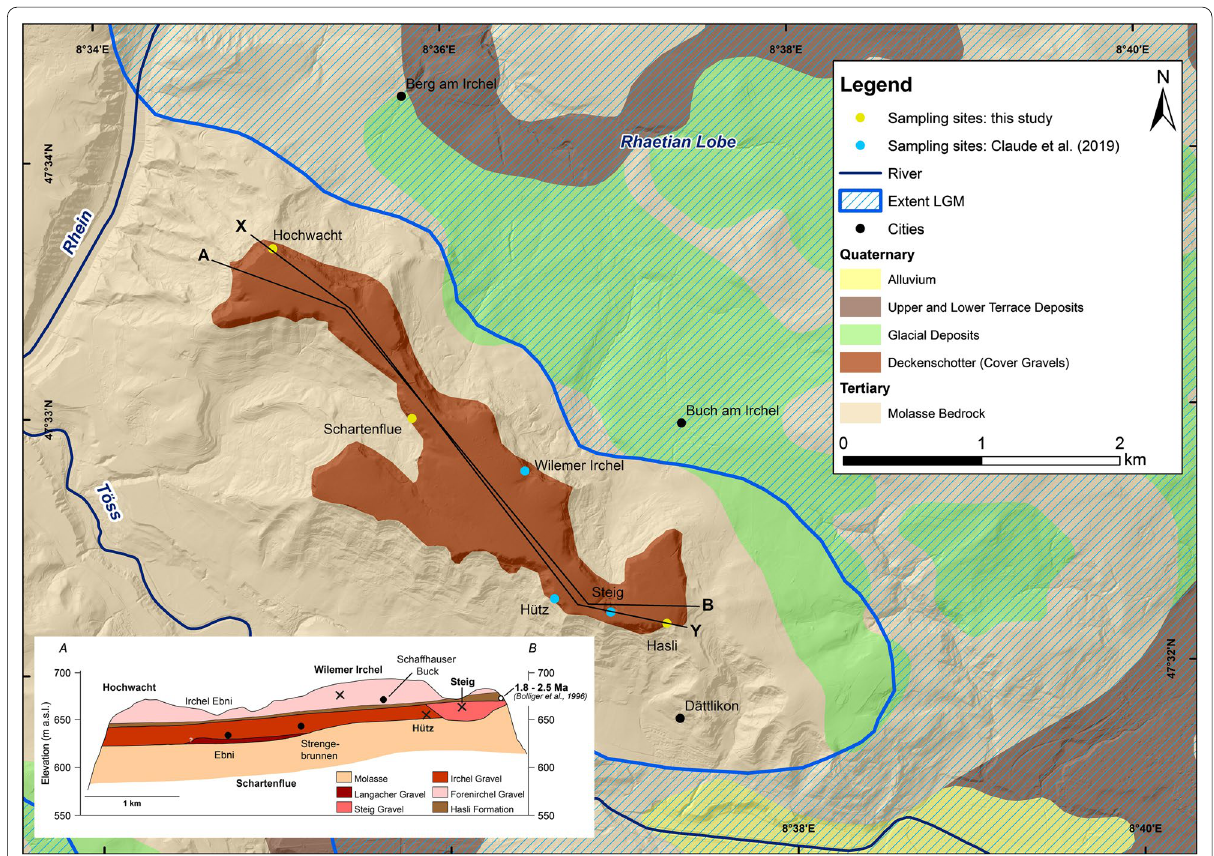
Fig. 2 Simplified geological map of the Irchel and the LGM extent of the Rhaetian Lobe. The solid line A–B shows the cross-section on the lower left corner (after Graf, 1993 and Claude et al., 2019) and the solid line X–Y the cross-section in Fig. 15. © Federal Office of Topography, swisstopo, CH-3084